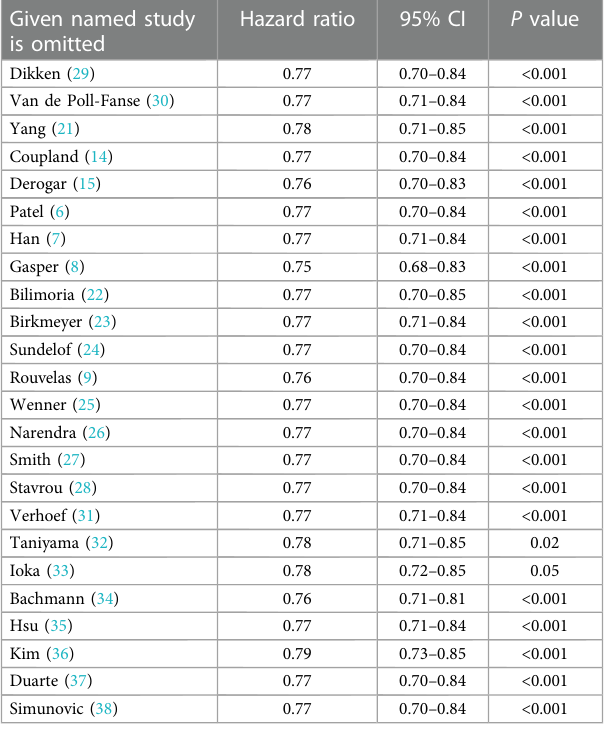
TABLE 4 Subgroup analyses of comparisons of the overall survivals between high- and low-volume hospitals. Subgroup HVH vs. LVH